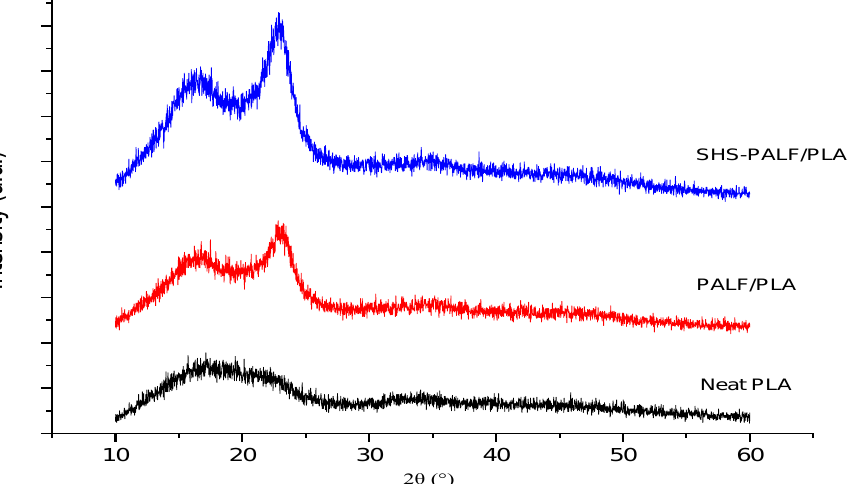
Figure 6. X-ray Diffraction (XRD) patterns of neat PLA, PALF/PLA, and SHS-PALF/PLA